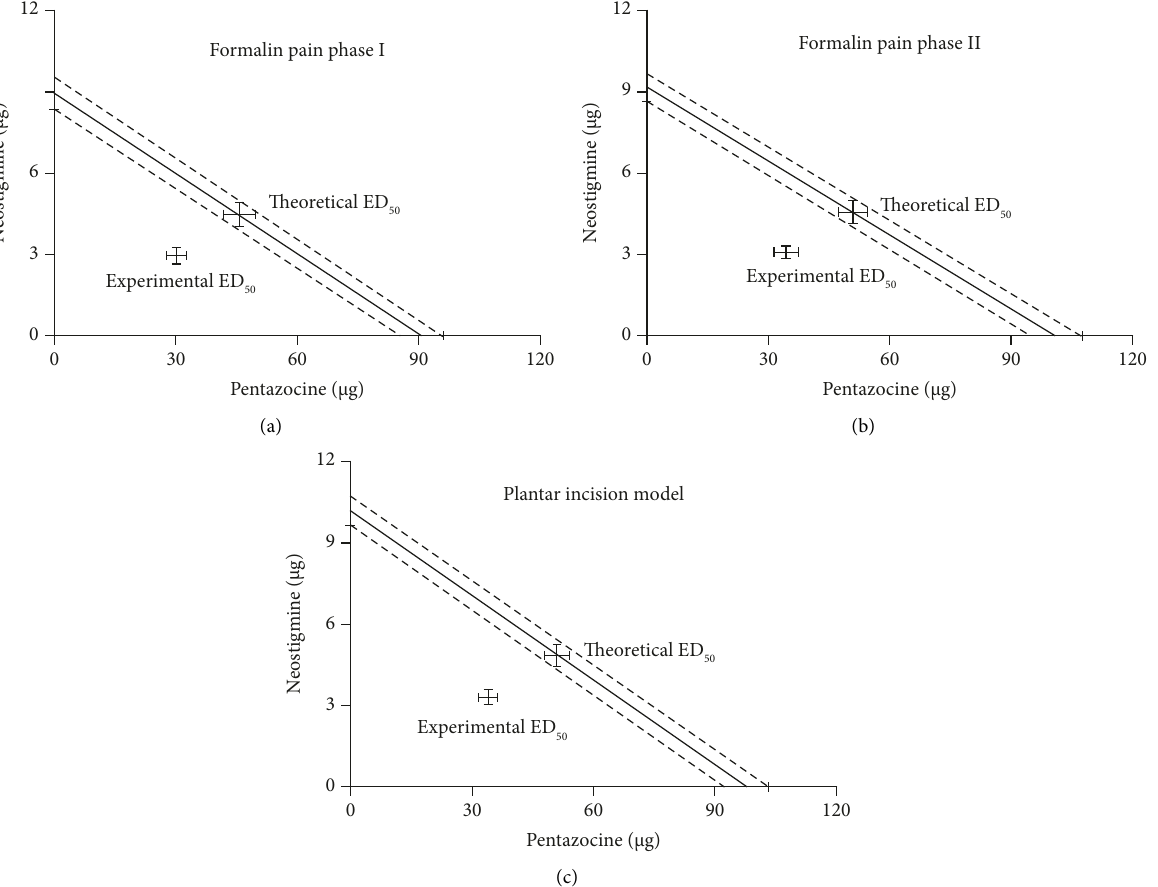
Figure 4: Shows the interaction between intrathecal pentazocine and neostigmine in phases I (a) and II (b) of the formalin tests and the plantar incisional pain model (c) which were analyzed using an isobologram. The x - and y -axes represent the ED 50 dose of pentazocine and neostigmine, respectively. The lines connecting the ED 50 points are the theoretical additive lines and the theoretical additive points for the drug combinations. The theoretical additive value was significantly higher than the experimental ED 50 value of the combination of the two drugs. The experimental ED 50 values were significantly below the lines of additivity, indicating a synergistic